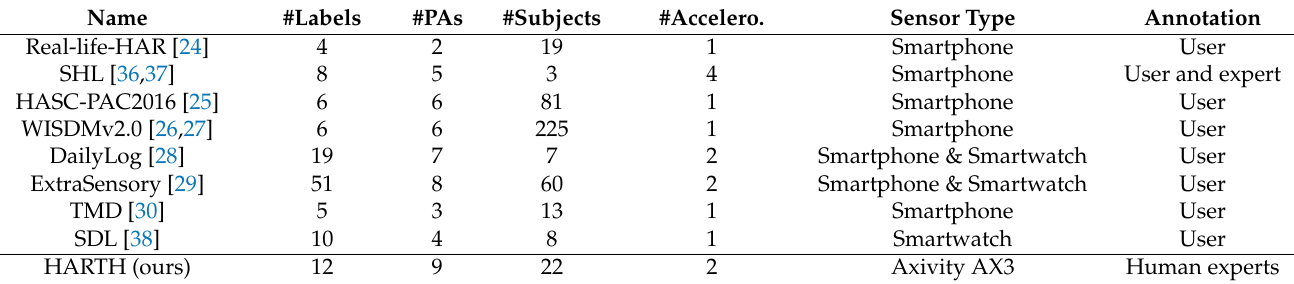
Table 1. This table shows the main characteristics of eight different publicly available HAR accelerometer-based datasets, and our HARTH. We consider the symbol “#” as an abbreviation for “number of”, “PAs” for “physical activities” and “accelero.” for